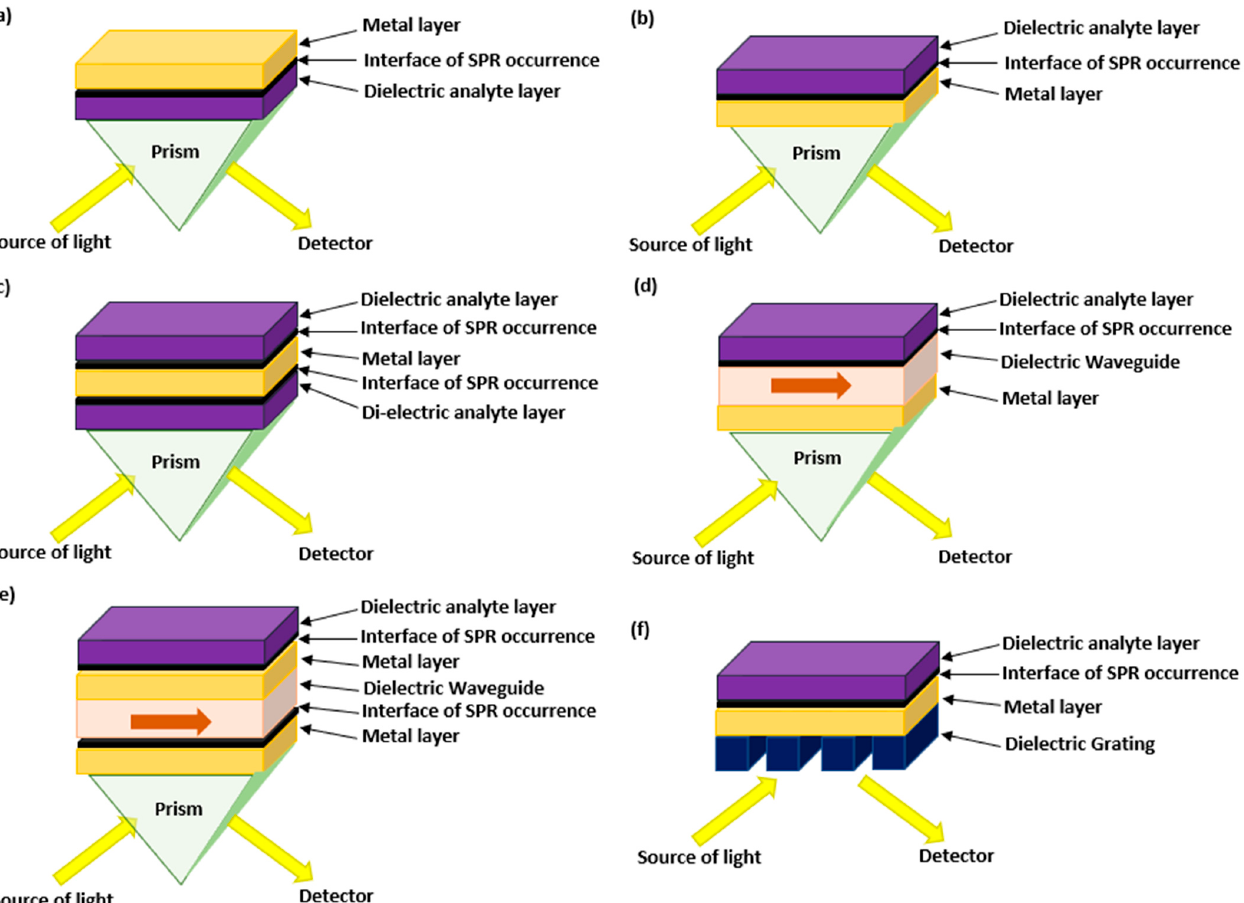
Figure 4. Common configurations in the SPR planar structures including ( a ) Otto configuration, ( b ) Kretschmann configuration, ( c ) long-range SPR, ( d ) plasmon-waveguide resonance, ( e ) waveguide- coupled SPR configuration, and ( f ) grating-induced SPR.